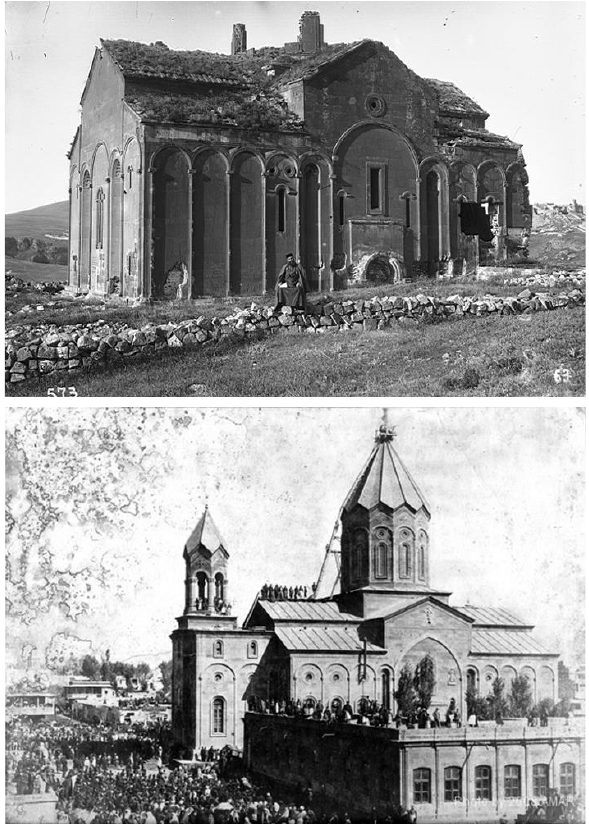
Figure 6. Facades of a typical vernacular house on